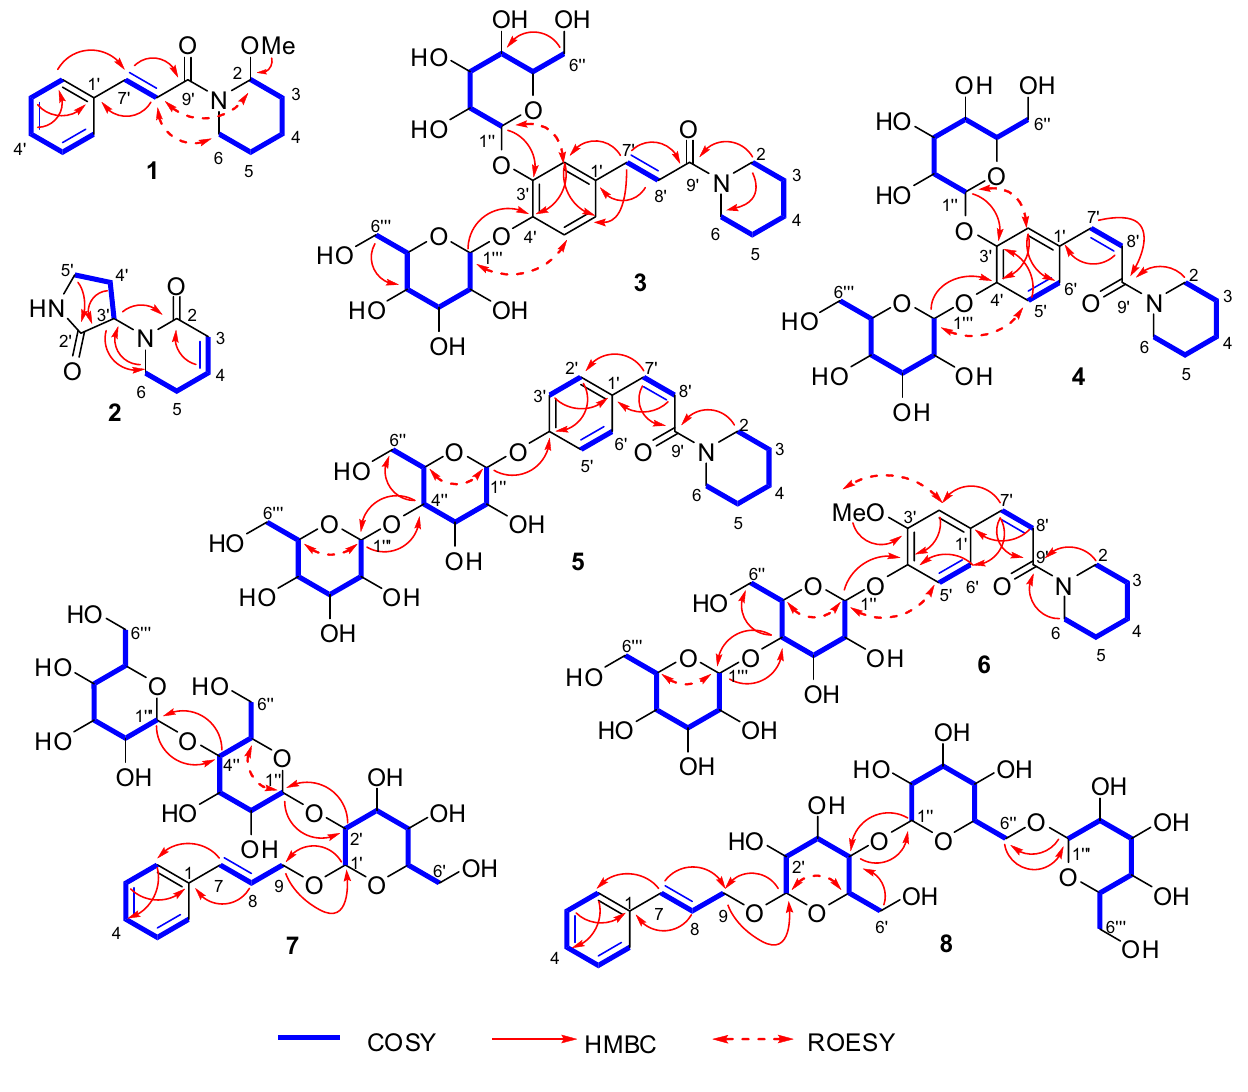
Fig. 2 Key 2D NMR correlations of compounds 1 – its NMR data with those of 3 and 4 , the amide moiety of 5 moiety in 4 was confirmed. The HMBC correlations (Fig. 2) was deduced to be ( Z )- N - p -coumaroylpiperidine, which was from H-1 ′′ to C-3 ′ and from H-1 ′′′ to C-4 ′ suggested the two supported by the COSY and HMBC correlations (Fig. 2). sugars were located at C-3 ′ and C-4 ′ , respectively. Thus, the The linkage of the sugars and genin was determined to be structure of retrofractoside B ( 4 ) was determined to be ( Z )- N -(3,4-di- O - β - d -glucopyranosyl) caffeoylpiperidine. The molecular formula of retrofractoside C ( 5 ) was and C-1 ′′′ as well as the ROESY correlations of H-1 ′′ /H-5 ′′ determined to be C H NO , based on the 13 C NMR data 26 37 12 and the COSY correlations of H-5 ′′ /H-6 ′′ (Fig. 2). There- (Table 3) and the HRESIMS ion peak at m/z 578.2206 [M fore, retrofractoside C ( 5 ) was determined to be ( Z )- N - p - + Na] + (calcd for C H NNaO , 578.2214). The 1 H and 26 37 12 13 C NMR data of 5 (Table 3) indicated the presence of two coumaroylpiperidine 4 ′ - O - β - d -glucopyranosyl-(1 → β -glucopyranosyl groups [ δ 4.96 (d, J = 7.8 Hz) and 4.43 H (d, J = 7.9 Hz)], a p -disubstituted phenyl ring [ δ 7.31 H (2H, br d, J = 8.7 Hz) and 7.07 (2H, br d, J = 8.7 Hz)], a Z -double bond [ δ 6.64 (d, J = 12.6 Hz) and 5.97 (d, J = H 12.6 Hz)], and a carbonyl group [ δ 169.8]. By comparing C 1 3